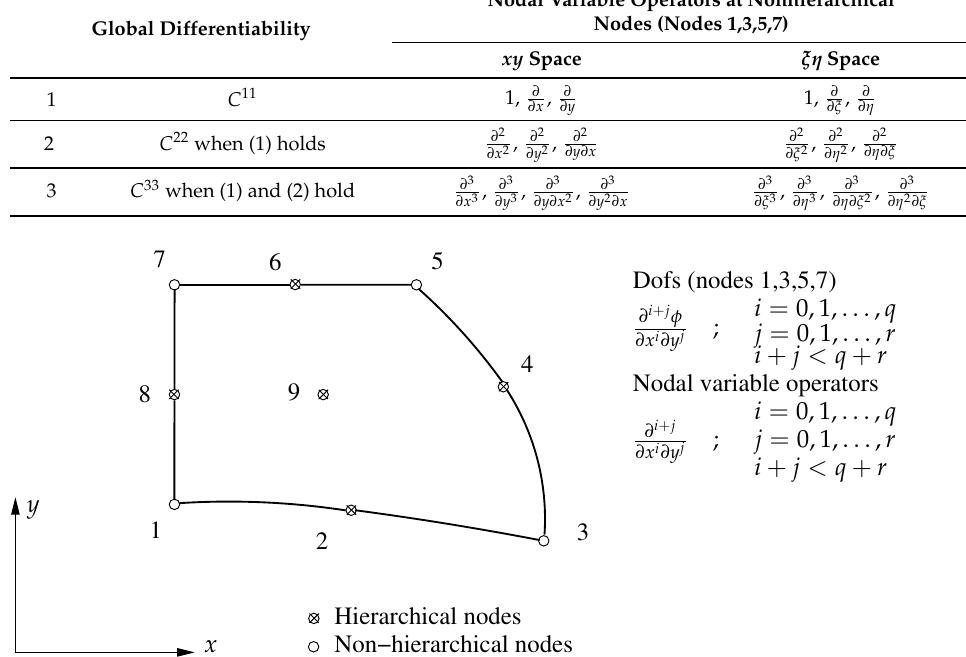
Figure 4. Nodal variable operators and dofs for nonhierarchical nodes: C ij ( ¯ Ω e xy ) .